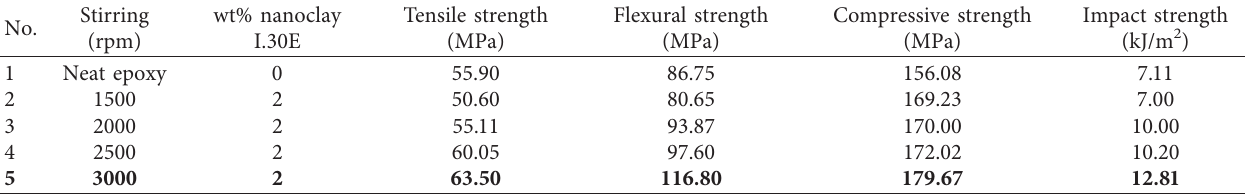
Table 5: Effect of mechanical stirring speed on mechanical properties of epoxy Epikote 240/nanoclay I.30E nanocomposite materials. No.